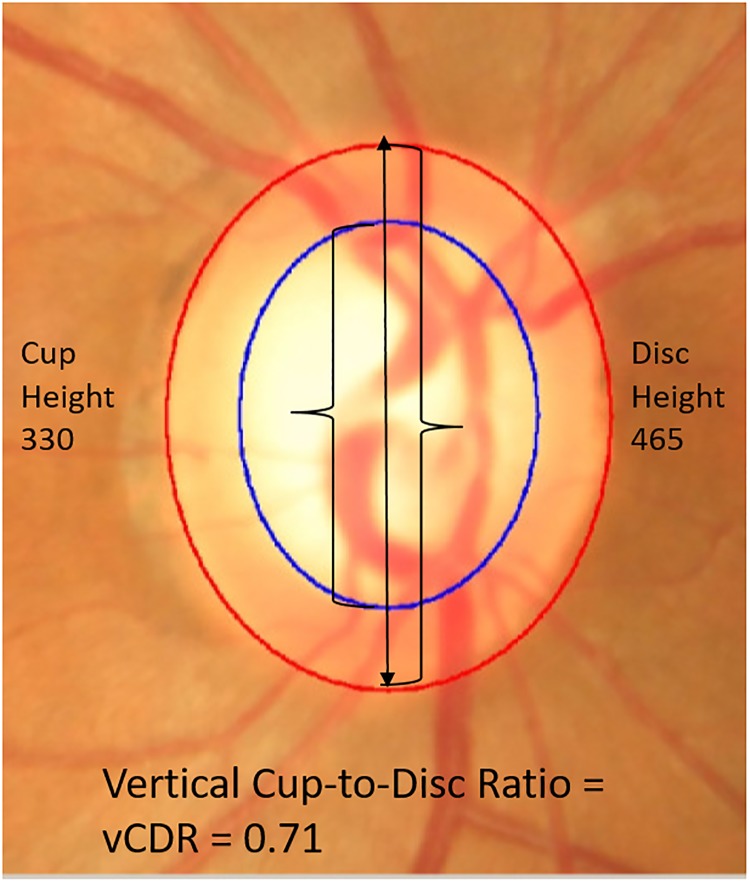
Example of vertical cup/disc ratio.Here, the boundaries of the cup and disc were determined using the ORIGA-GT software (modified from [16]). This software generates boundaries by fitting two ellipses using human expert landmark identification and least squares fitting. The cup boundary is given in blue; the disc boundary is in red. In the text, this is referred to as semi-automated segmentation.